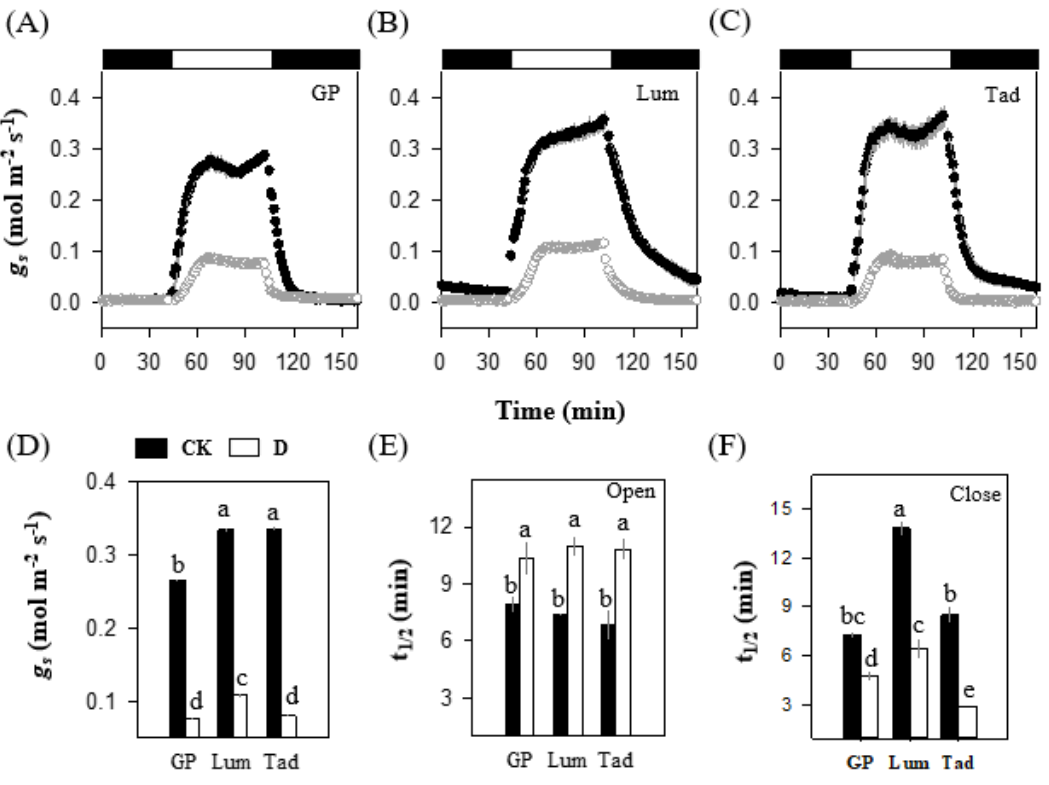
Figure 4. Dynamics of stomatal conductance ( g s ) and time constants for stomatal kinetics under light–dark transition. ( A – C ) Dynamics of g s at the leaf level in controlled light environments in three species. The light intensity was alternately switched between light (1400 µ mol m − 2 s − 1 PAR, white bar) and dark (black bar) at 40 min and 100 min. ( D ) Steady-state g s max during the high-light (1400 µ mol m − 2 s − 1 PAR, white bar) period. ( E , F ) Halftime for stomatal opening (t 1/2open ) and closing (t 1/2close ) determined by photosynthesis measurements. Data are presented as the means ± se ( n = 3–4). Different letters above the error bars indicate significant differences at p < 0.05.